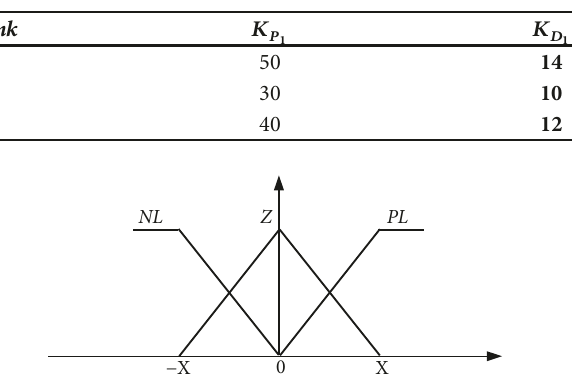
Table 3: The assumed parameters of the PD controller.